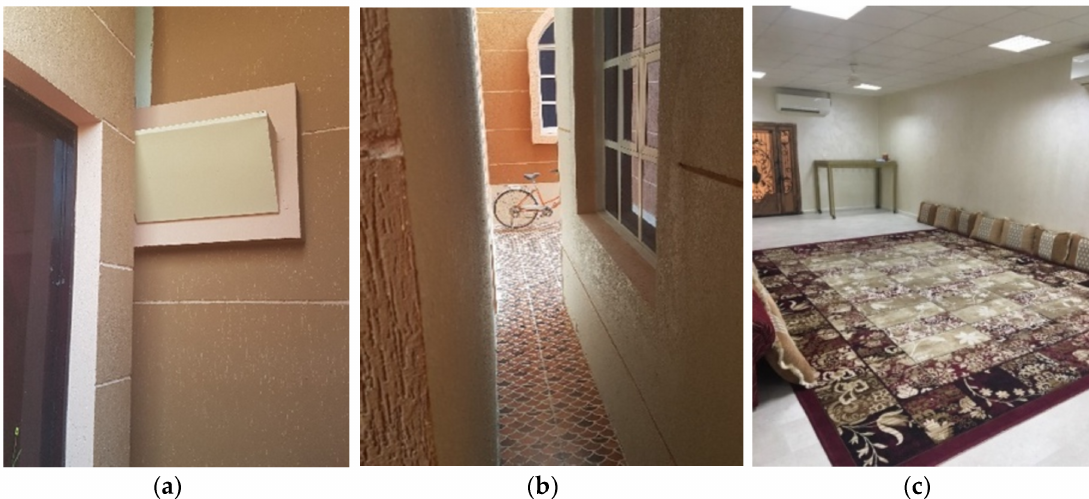
Figure 2. Examples of residents’ adaptations of their houses: ( a ) The extension was too close to the existing part, so the residents were forced to close the bathroom’s window for privacy purposes, leaving the bathroom almost without ventilation. ( b ) The new extended part is located less than 1 m away from the existing house; hence, the window became useless. ( c ) The residents developed a new living room located in the middle of the ground floor, and it has no windows, so there is no natural lighting or